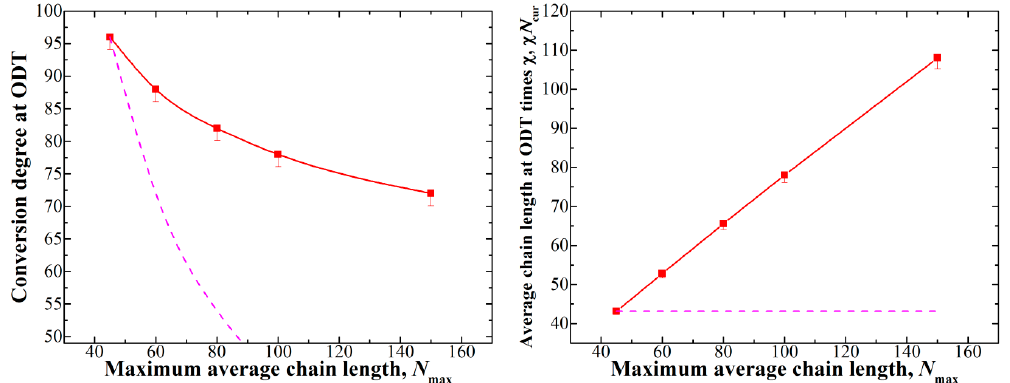
Figure 3. Left : dependence of the conversion degree at which the ODT occurs depending on the maximum average chain length N max ; Right : dependence of the χ N cur of the ODT on N max . For N max = 100, the box size of 60 3 was used, while for N max = 150, the box size was equal to 80 3 . The dashed lines show the behavior if χ N cur at the ODT was constant and are given as a guide for the eye.